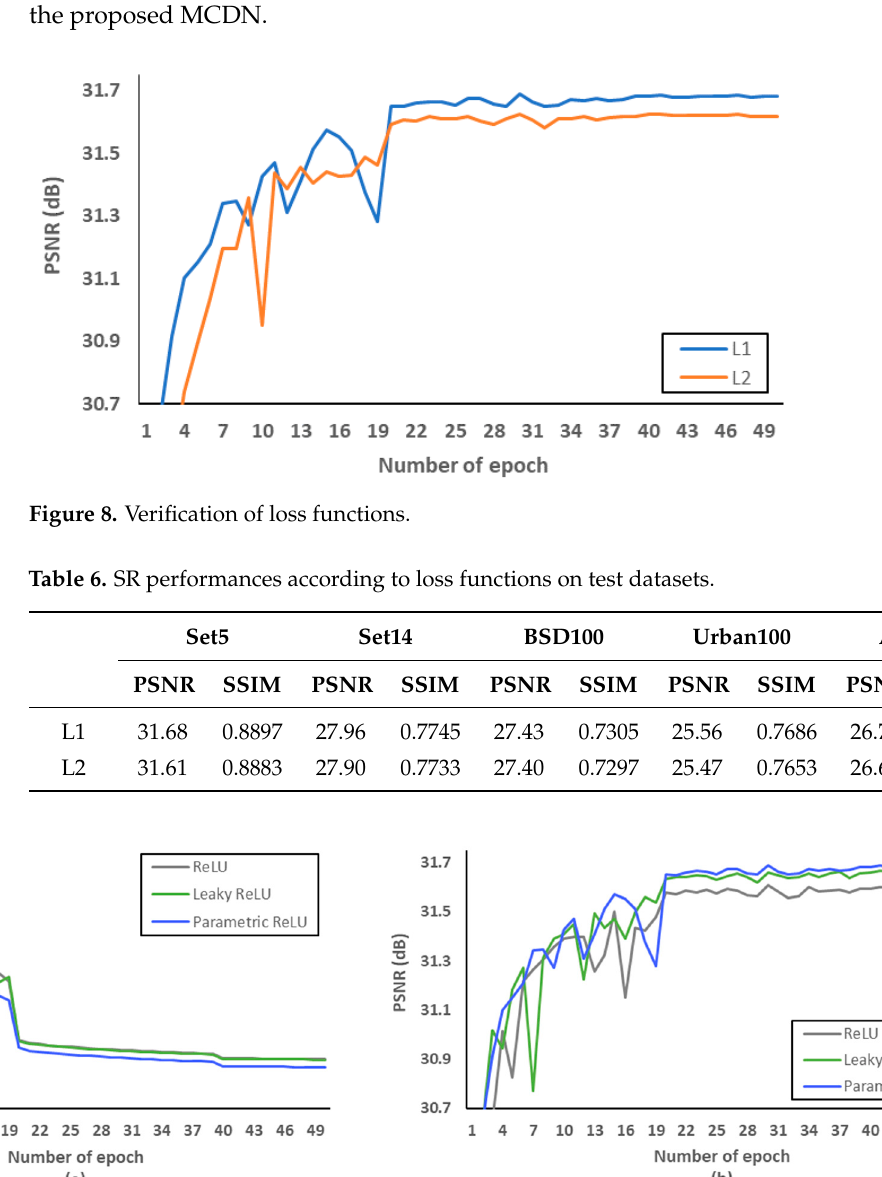
Figure 10. Verification of the number of MCDB (M) in terms of SR performance. ( a ) L1 loss per epoch. ( b ) PSNR per epoch.